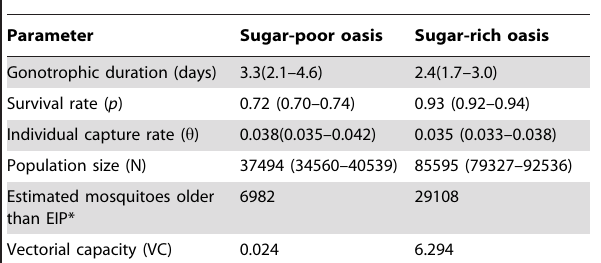
Table 1. Estimates of population parameters and malarial vectorial capacity of Anopheles sergentii in two oases with different levels of sugar supply (95% confidence intervals are in